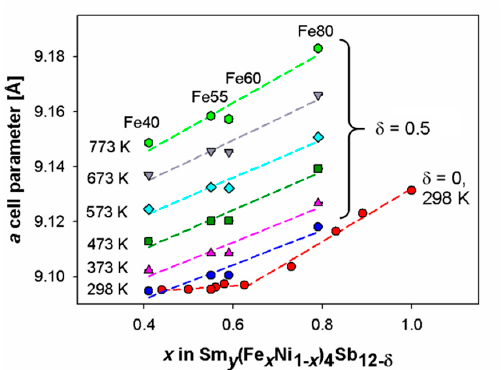
Figure 8. Trend of the a lattice parameter as a function of the Fe content ( x ) at each temperature; the room temperature values for the Sm y (Fe x Ni 1 − x ) 4 Sb 12 system (red circles), taken from ref. [29], are also reported as a term of comparison.